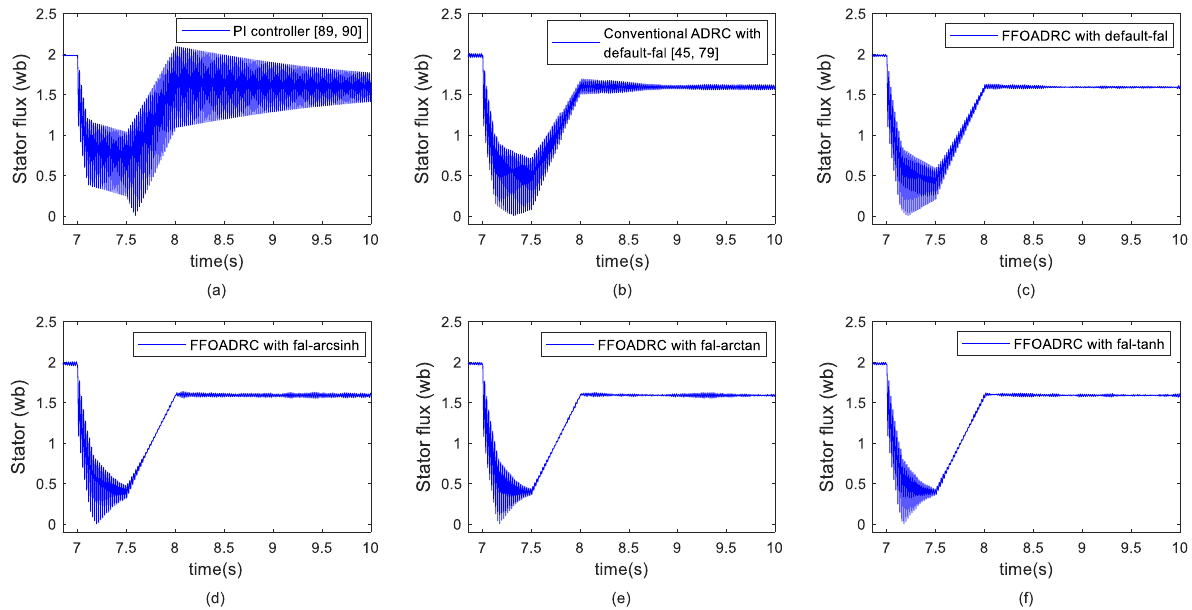
Fig. 17 Stator flux during symmetrical voltage sag for R crowbar 0.8 Ω: ( a ) PI controller [89, 90], ( b ) Conventional ADRC with default-fal [45, 79], ( c ) = FFOADRC with default-fal, ( d ) FFOADRC with fal-arcsinh, ( e ) FFOADRC with fal-arctan, and ( f ) FFOADRC with